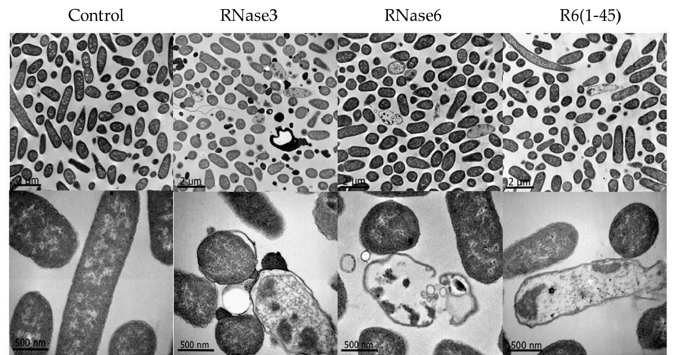
Figure 3. Transmission electron microscopy (TEM) micrographs for E. coli cultures incubated in the absence and presence of RNase3, RNase6 and RN6(1–45). Two magnifications ( upper and lower panels) are shown for each condition to visualize the extent of bacteria aggregates and cell morphology. Scale bars correspond to 2 µm and 500 nm, respectively.